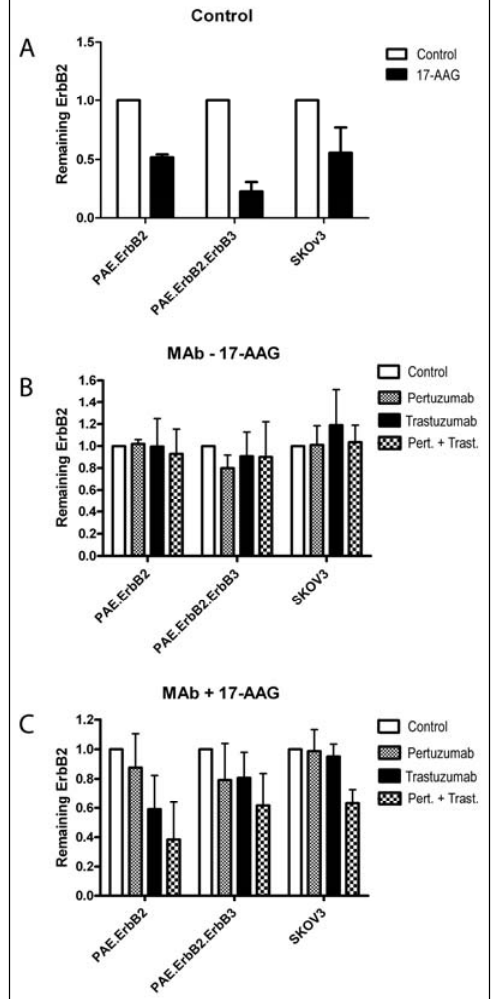
Figure 6. Quantification of pertuzumab-, trastuzumab-, and/or 17-AAG-induced degradation of ErbB2. The intensity of the bands in the Western blots demonstrated in Figure 5 was measured, and for each condition the intensity for ErbB2 was normalized to tubulin. The calculated values thus reflects the amount of ErbB2 remaining in cells after the various treatments. ( A ) Effect of incubation with 17-AAG. The relative intensity of ErbB2 in cells treated with CHX only was set to 1; ( B ) Effect of incubation with pertuzumab and/or trastuzumab. The relative intensity of ErbB2 in cells treated with CHX only was set to 1; ( C ) Effect of incubation with antibodies and 17-AAG in combination. The relative intensity of ErbB2 in cells treated with 17-AAG and CHX, but no antibodies, was set to 1, and the control values do thus correspond to the respective 17-AAG values in ( A